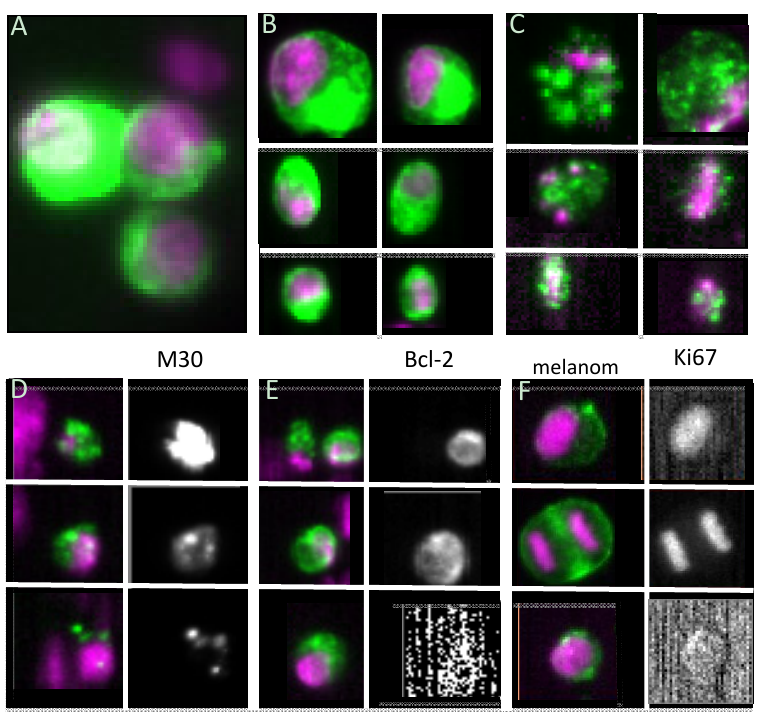
Figure 2. CTC heterogeneity. In all panels except for F, green represents CKs 8, 18 and 19 and purple the nuclear staining. ( A ) Cluster of three large CTC; ( B ) Individual CTC varying in size and shape; ( C ) CTC varying in size and shape exhibiting distinct punctuation of the CK staining; ( D ) CTC stained for CKs and nuclei (left) and staining of cleaved CK18 identified through M30 staining (right). Note the association between the punctuated CK staining and the M30 staining; ( E ) CTC stained for CKs and nuclei (left) and bcl-2 staining (right). Notice that only one of the CTC on the top row exhibits punctuated CK staining; ( F ) Left column showing overlay of CTC from a melanoma patient, staining of HMW-MAA (green) and nuclei (purple) and on the right column Ki67